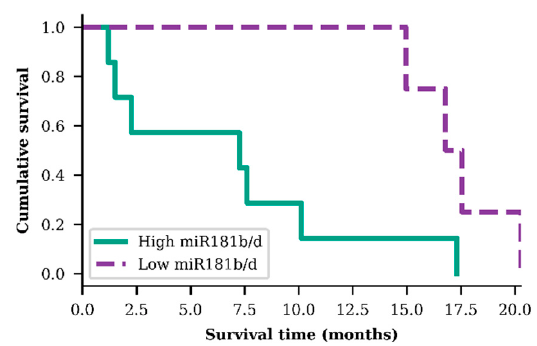
Figure 4. Survival analysis of both exosomal miR-181b and miR-181d high and low levels in older (> 55.3 years) glioblastoma patients, diagnosed with IDH1 wild type and methylated MGMT promoter ( p = 0.025)